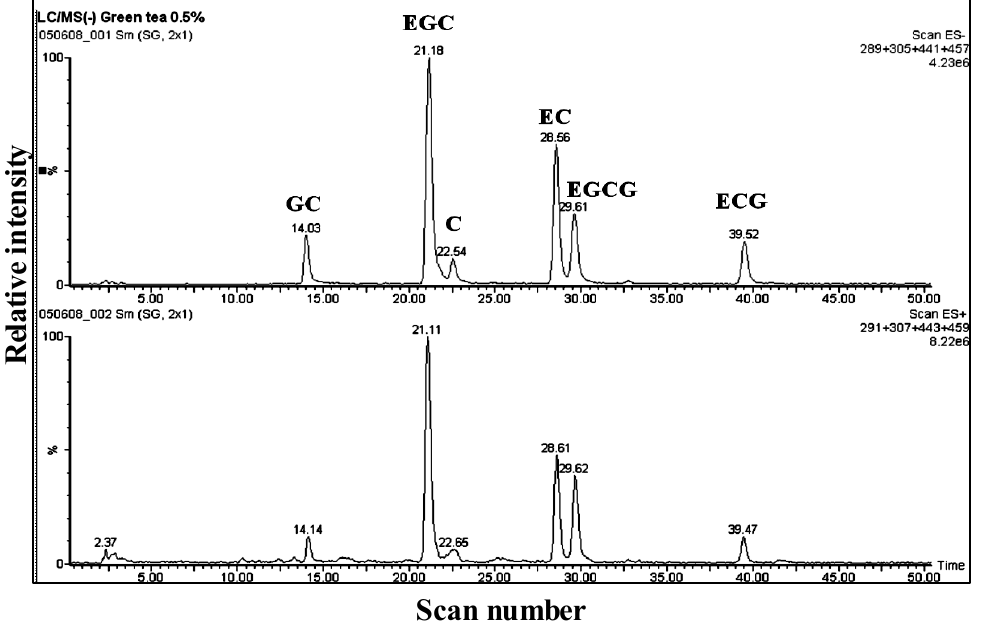
Figure 1. LC/ESI-MS analysis of aqueous extract of green tea (GTE). Reconstructed ion chromatogram (RIC) obtained in both positive and negative scan modes. GC, gallocatechin; EGC, epigallocatechin; C, catechin; EC, epicatechin; EGCG, epigallocatechin gallate; ECG, epicatechin gallate.